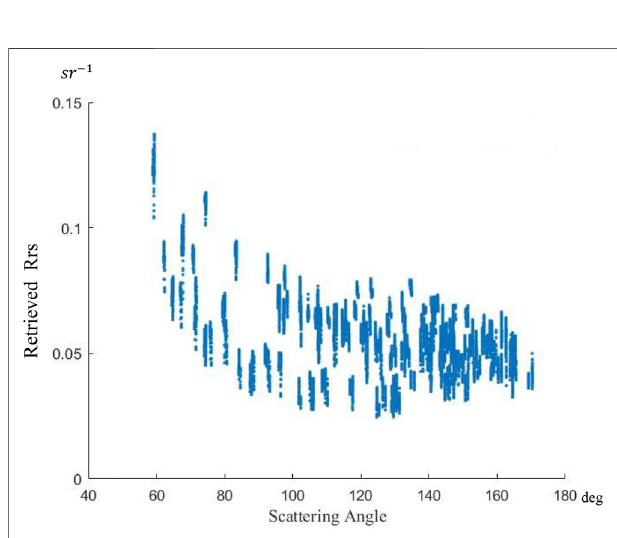
FIGURE 2 | R rs retrieved over Taihu Station plotted against scattering